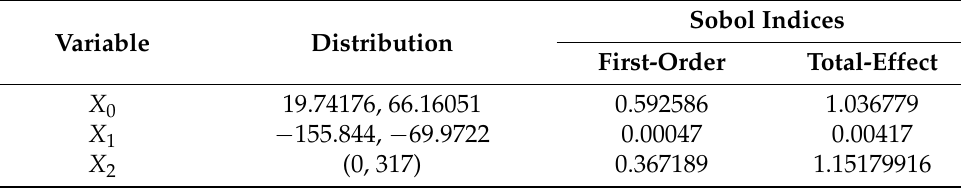
Table 4. First-order and total-effect Sobol indices measuring model sensitivity to parameters in symbolic expression for the estimation of the number of confirmed cases for the entire U.S. ( X 0 latitude, X 1 longitude and X 2 day).